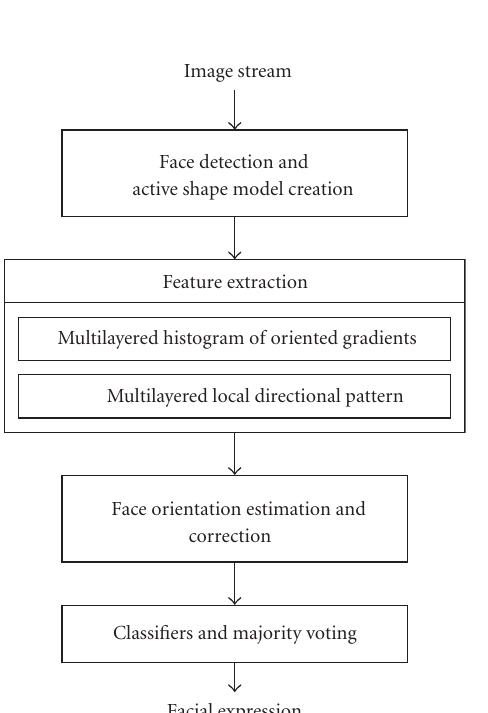
Figure 1: Framework of the system.